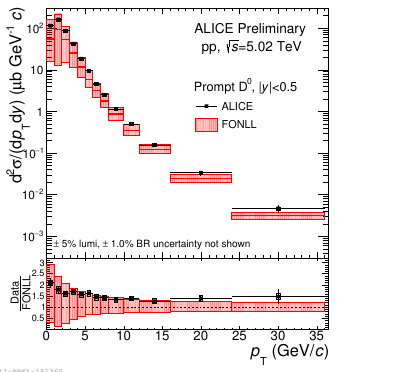
Figure 1. Left: The p T -differential production cross sections for prompt D 0 mesons in pp collisions at √ s = 5.02 TeV compared to FONLL calculations. Right: The differential cross-section of B + production as a function of p T . The solid (open) circle points correspond to the measurement of ATLAS (CMS). Predictions of the FONLL calculation are compared to the experimental